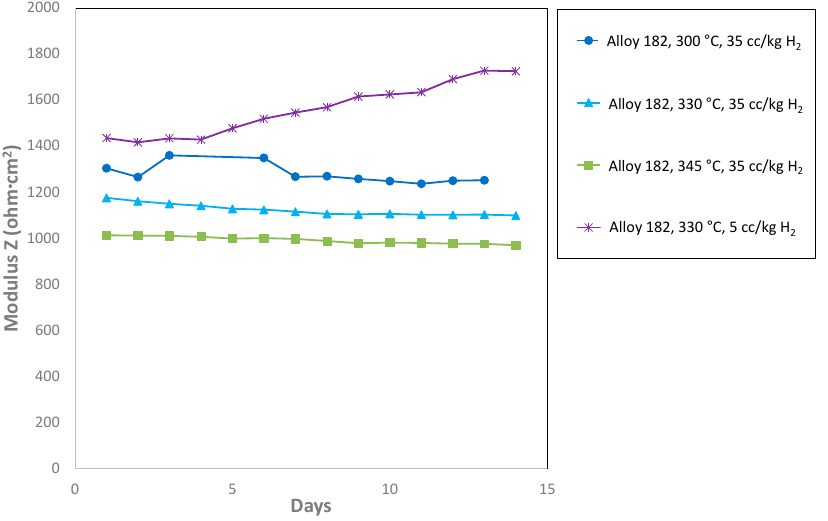
Figure 12. Modulus of the impedance at low frequency as a function of time.